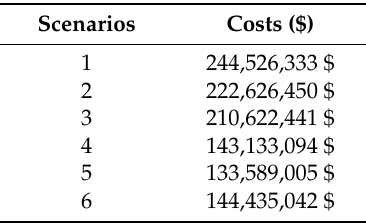
Table 2. Cost results in detail.